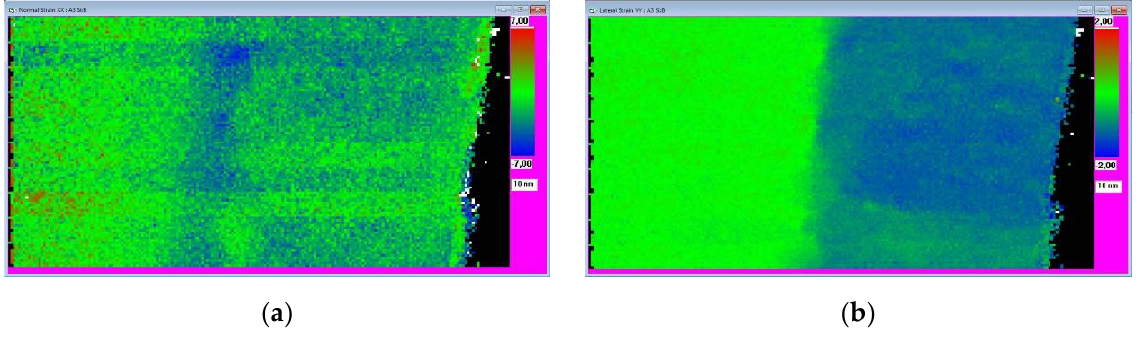
Figure 4. Two-dimensional strain distribution in an Si:B sample. The layer is on a bulk substrate. The top surface (covered with protecting Pt during FIB cutting) is on the right side of the map. The 4D-ED dataset was recorded from the area shown in Figure 1c. Pixels in the map are black, where it was impossible to fit a grid to the corresponding pattern (e.g., protecting layer). ( a ) Normal component. ( b ) Lateral component.